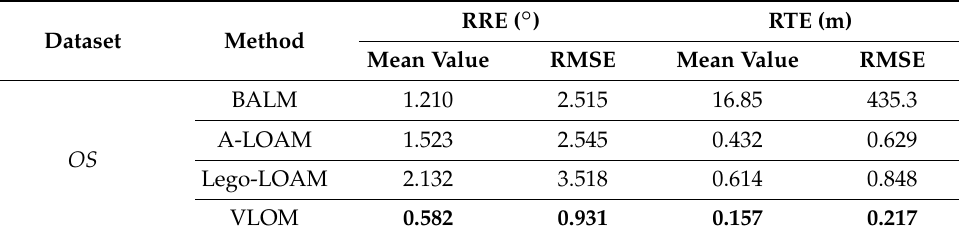
Table 3. RPEs of BALM, A-LOAM, Lego-LOAM, and VLOM produced by EVO on OS . The values in bold indicate the best precision.